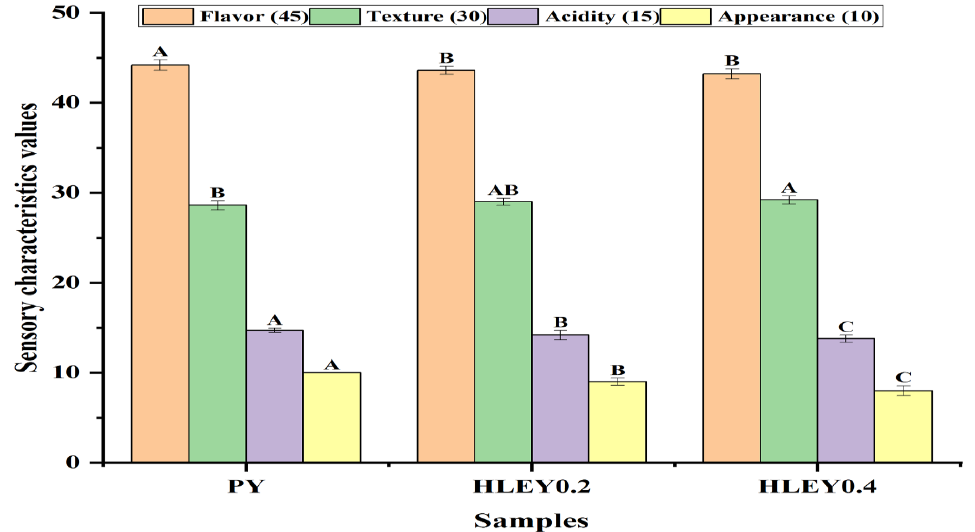
Figure 1. Sensory characteristics of yogurt fortified with aqueous Hawthorn leaf extract. Values with the different superscript letters are significantly different at ( p ≤ 0.05). Mean values ± standard deviation, n = 10. PY, plain yogurt; HLEY0.2, yogurt containing 0.2% Hawthorn leaf extract; HLEY0.4, yogurt containing 0.4% Hawthorn leaf extract.